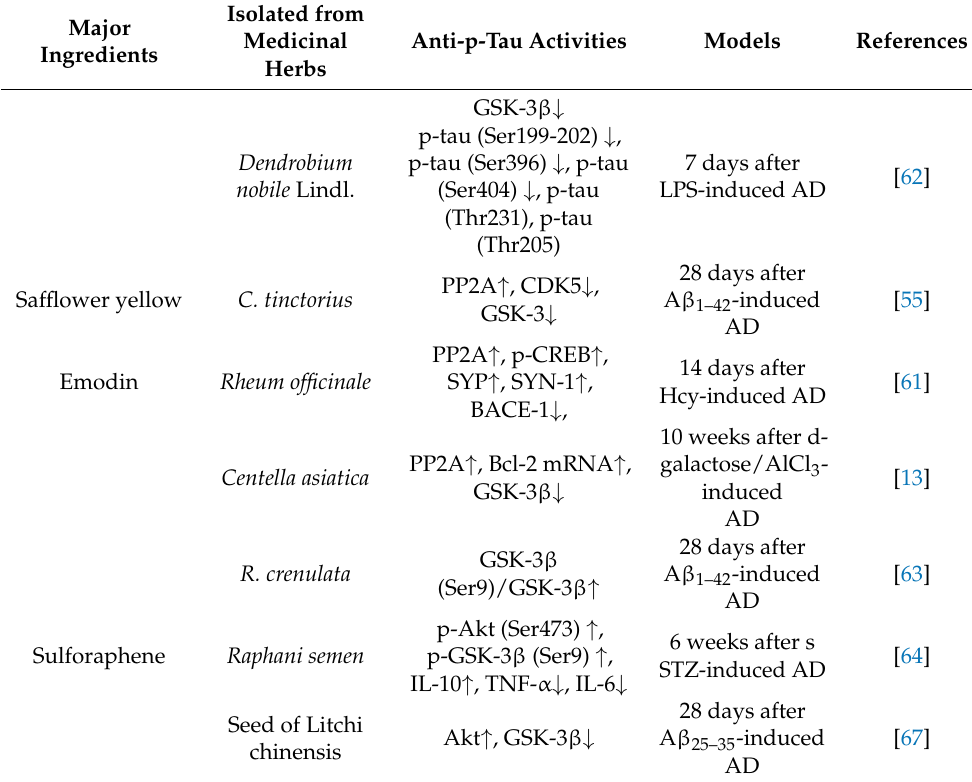
Table 3. MHDIs that downregulate tau hyperphosphorylation in AD animal